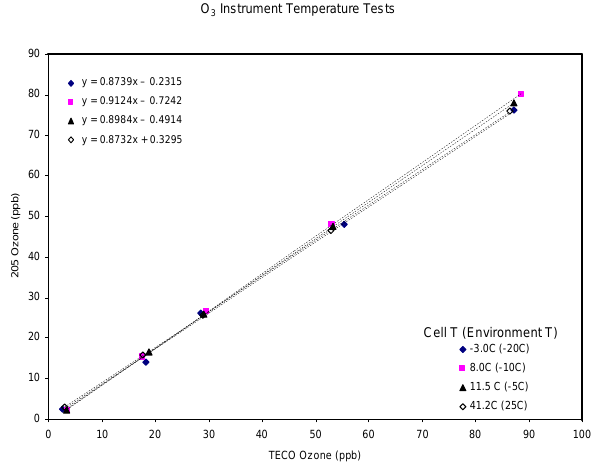
Fig. 4. Temperature dependent calibration of the ozone